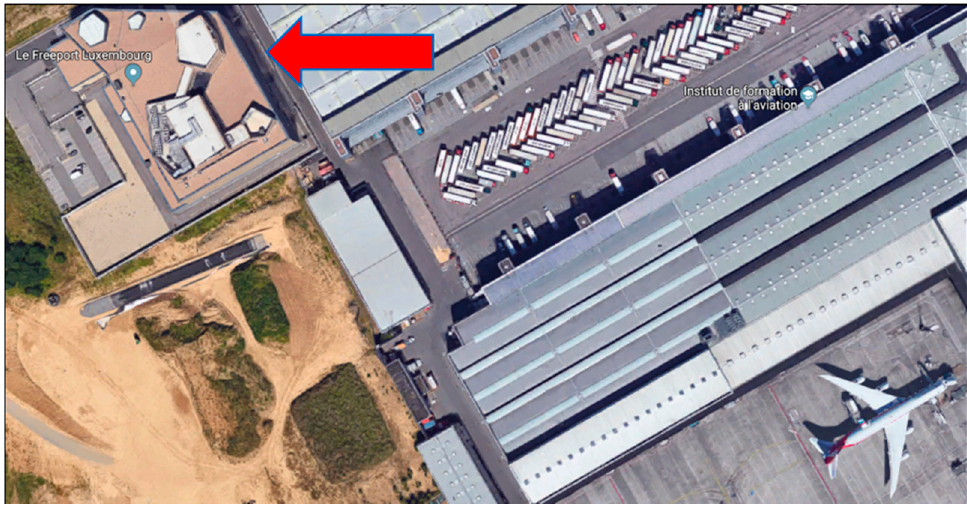
Figure 1. An aerial view of “Le Freeport” in relation to the air-cargo terminal (Google